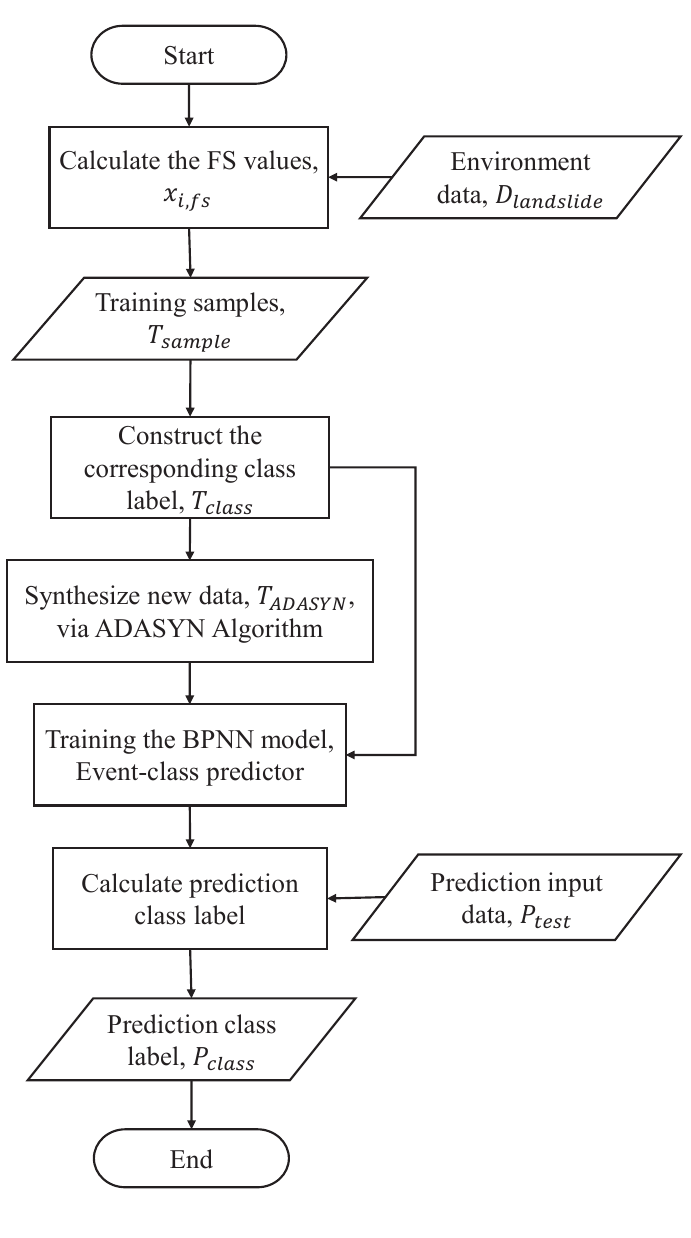
Figure 4. Flow of constructing the event-class